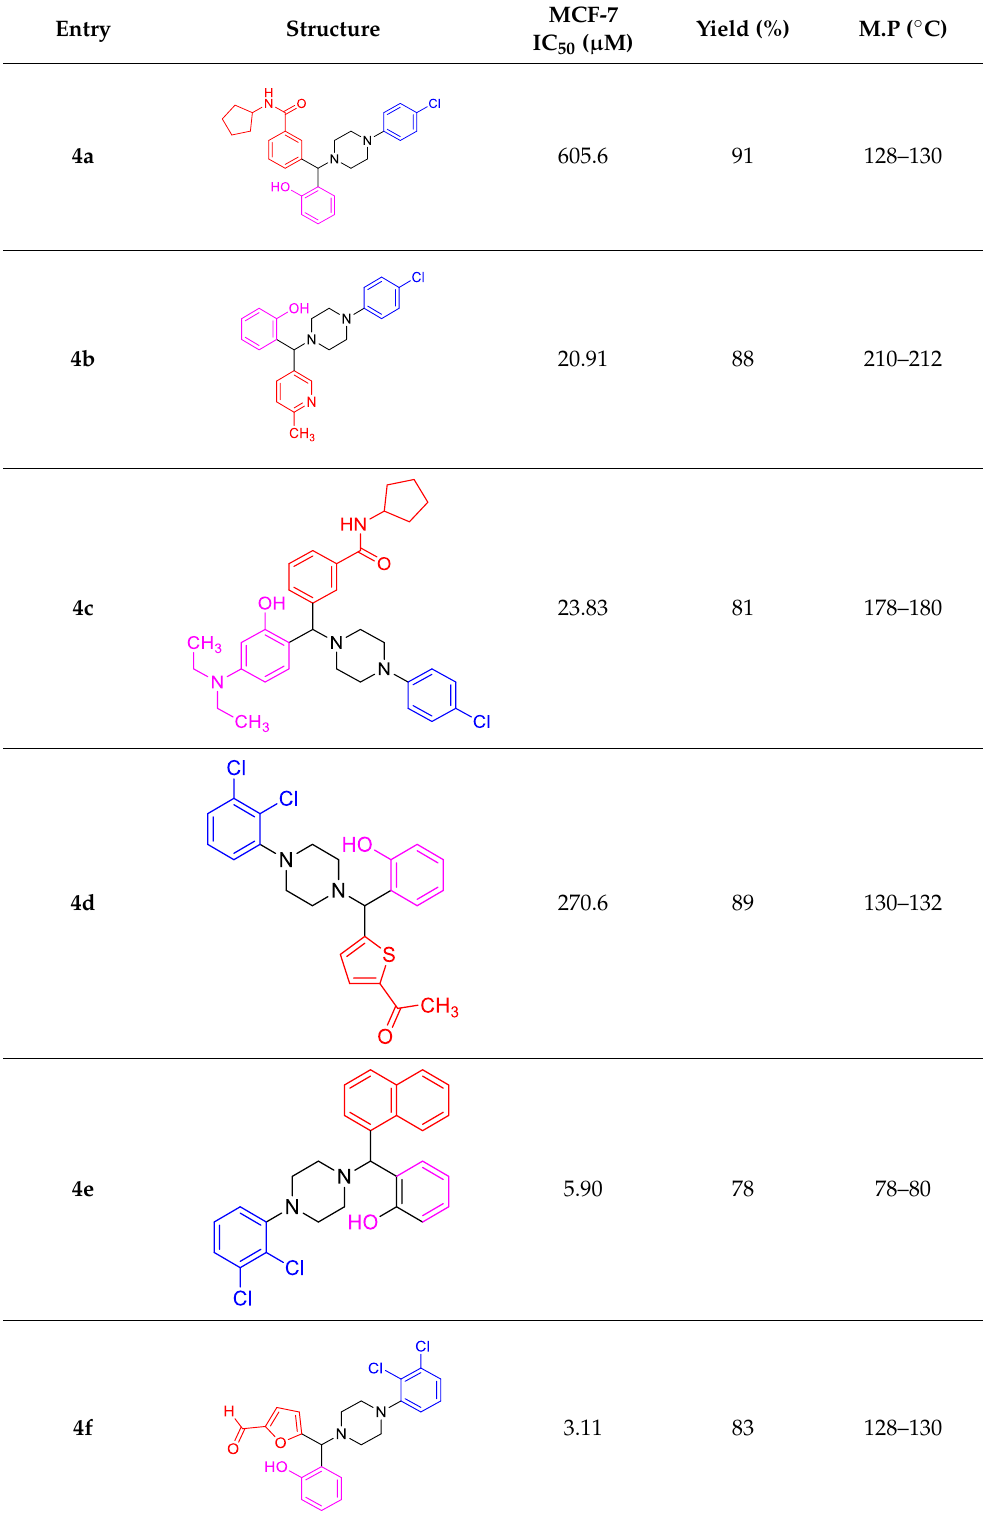
Table 1. Physical data and cell viability studies of NPB analogs in human mammary carcinoma (MCF-7 cells) cells. Entry Structure